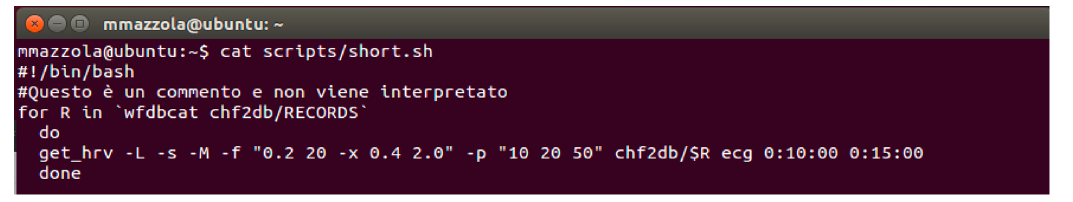
Figure 4 . Script for Short ‐ Term Analysis.